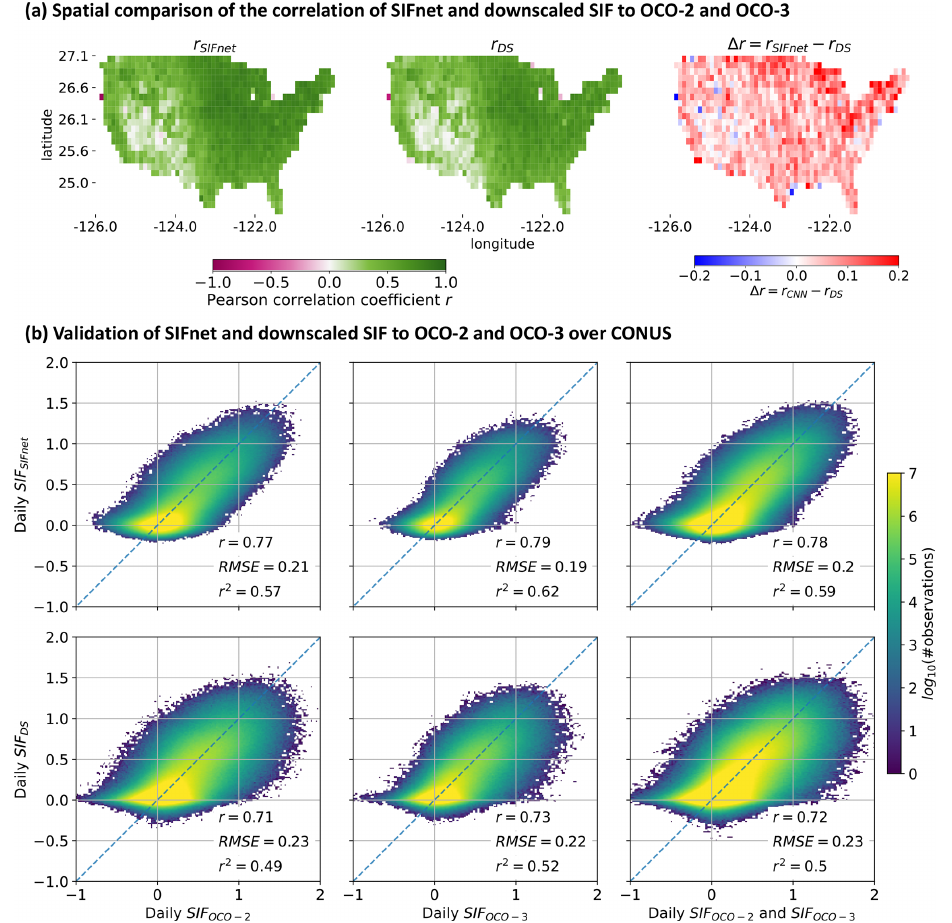
Figure 7. Validation of SIFnet and downscaled SIF to OCO-2 and OCO-3 SIF over CONUS. Comparison from April 2018 until March 2021 in 16d time steps. Daily OCO-2 and OCO-3 data are assigned to the closest 16d time step. Panel (a) shows the gridded correlation of the two products against the combined data of OCO-2 and OCO-3. We first compute the SIF data from SIFnet and downscaling estimate that falls into the OCO footprint. Then we assign every OCO footprint to the closest grid point on the 1 ◦ grid dependent on the center location of that footprint and compute the Pearson correlation coefficient. Panel (b) shows the scatter comparison of the weighted average of all grid cells on the 0.005 ◦ estimated SIFnet SIF (ours) and downscaled SIF (Turner et al., 2020) that fall into the OCO-2 or OCO-3